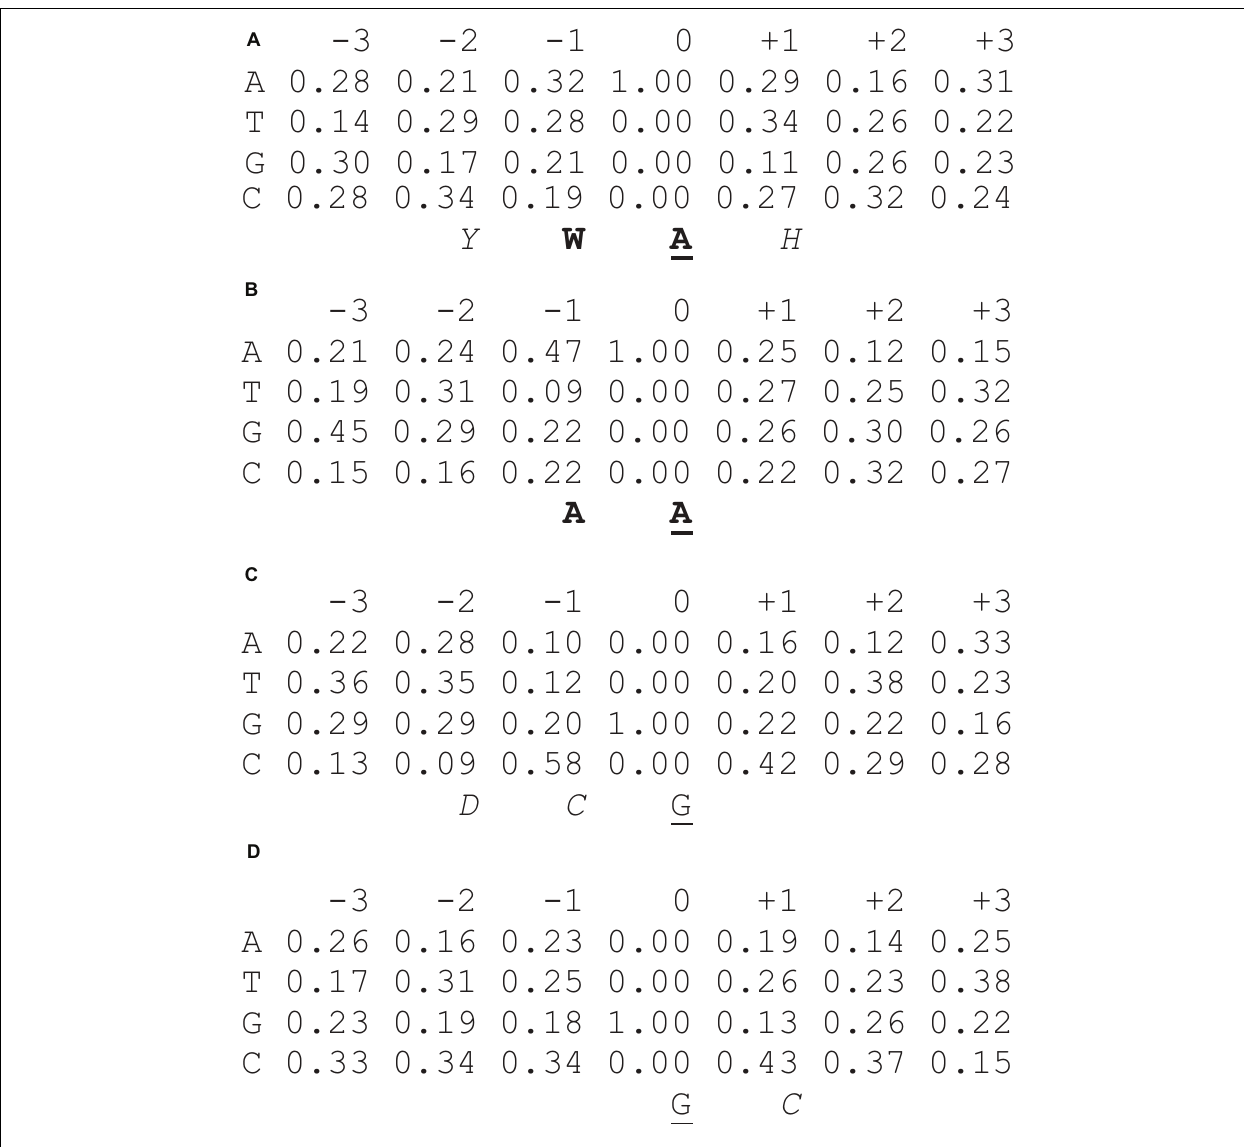
FIGURE 1 | Nucleotide frequency matrices for mutations at A:T sites [ (A) DNA pol η ; (B) pol θ ] and G:C sites [ (C) pol θ ; (D) DNA pol η ]. Known mutable motifs (consensus sequences) (Matsuda et al., 2001; Rogozin et al., 2001) are shown below each matrix in bold, whereas mutable positions are underlined. Putative (previously unobserved) parts of mutable motifs and potentially informative positions are italicized, W = A or T; Y = T or C; B = A, T or G; D = A, T, or G. Source of data: Supplementary Figures 2, 3 .